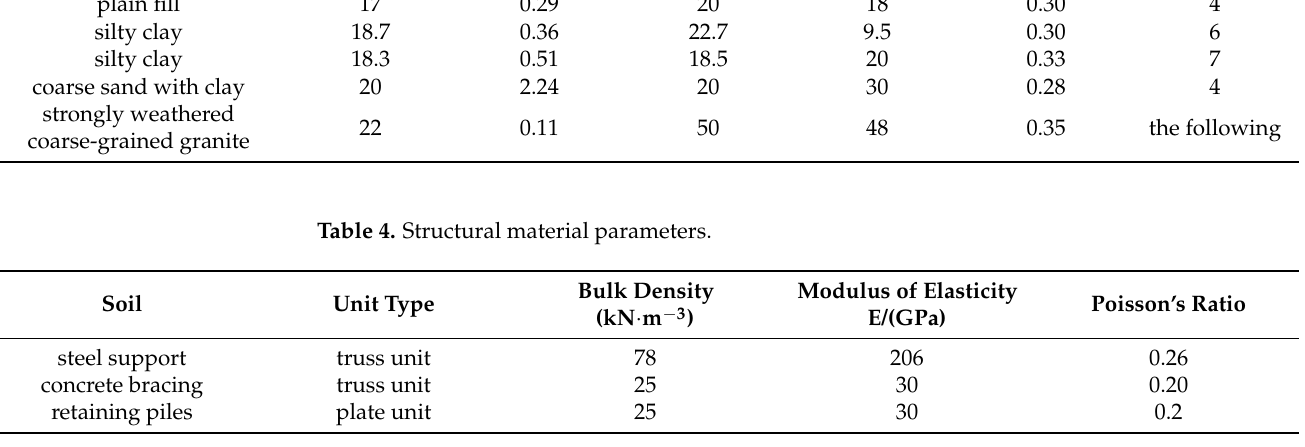
Table 3. Geotechnical layer parameters.